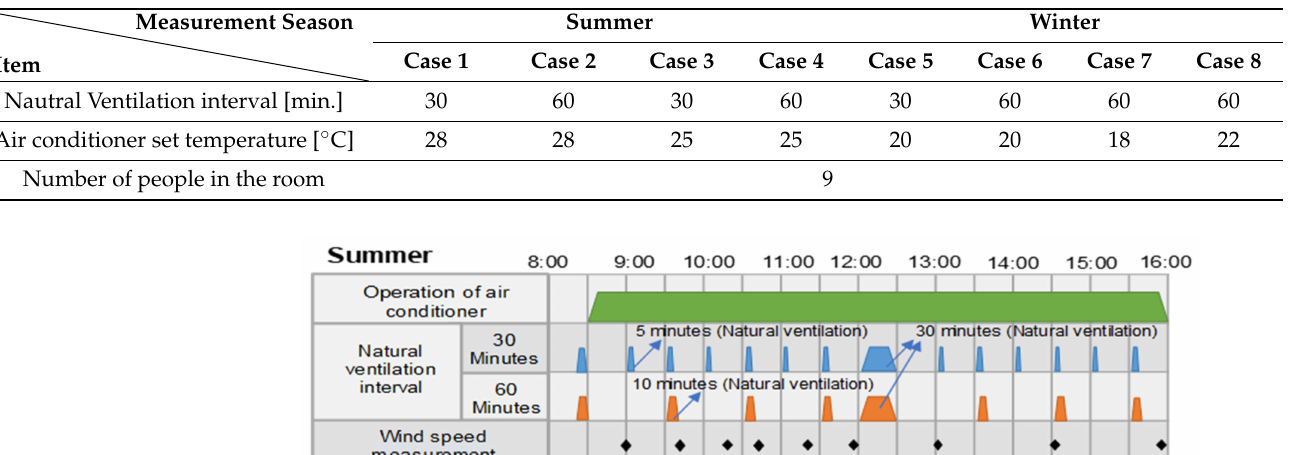
Table 2. Measurement conditions in summer and winter.